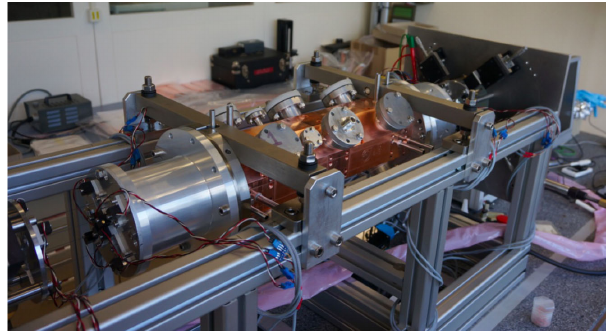
FIG. 5. The picture shows the extension parts, made of aluminum, attached to the extremities of a single module. These parts provide comparable boundary conditions to simulations.